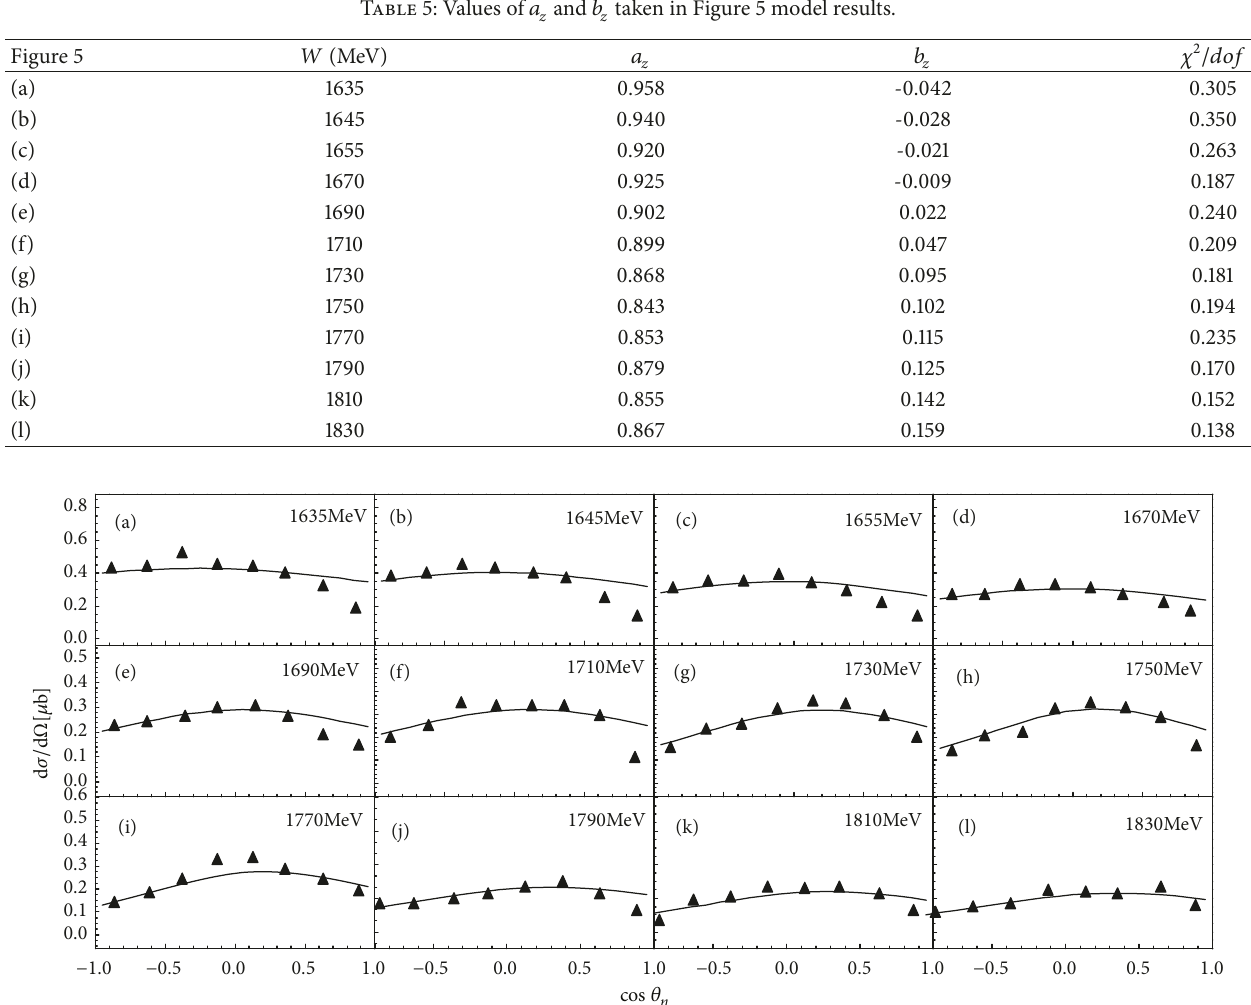
Figure 5: Same as Figure 4, but showing angular distributions for the different bins of final state energy 1635 MeV ≤ 𝑊 ≤ 1830 MeV.